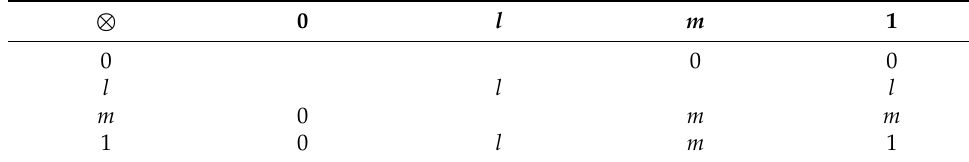
Figure 4. Lattice order relation on L . Table 7. The partial operation ⊗ .